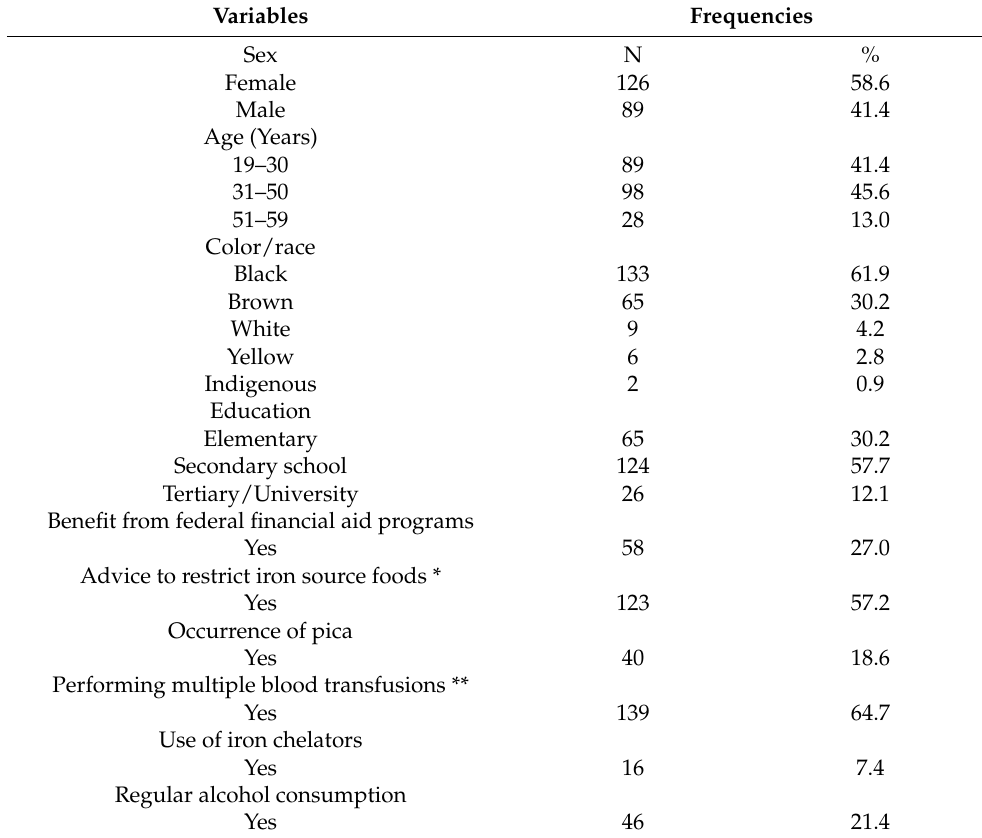
Table 1. Socioeconomic and clinical characteristics of the participants (N = 215).